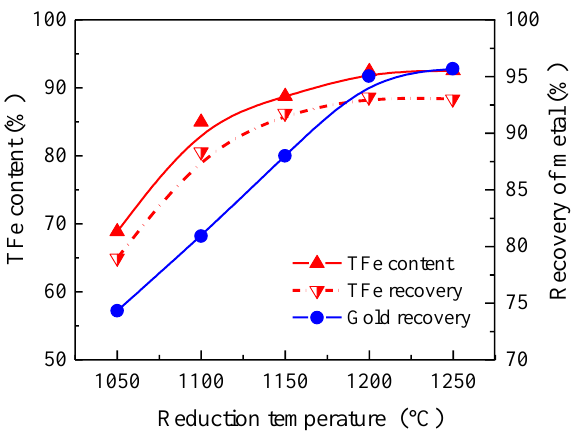
Figure 3. Effect of reduction temperature on the recovery of iron and gold from cyanide tailings. (Reduction conditions: reduction time of 90 min, coal dosage of 20 wt.% and CaO dosage of 15 wt.%).